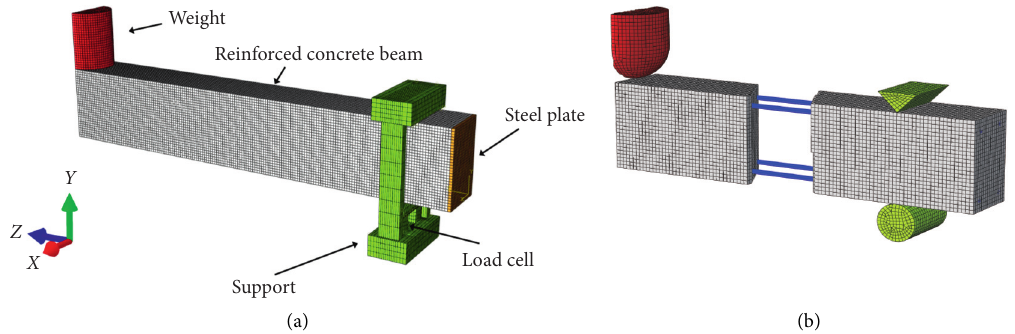
Figure 5: Numerical model for simply supported beams. (a) For Kishi’s tests. (b) For Adhikary et al.’s